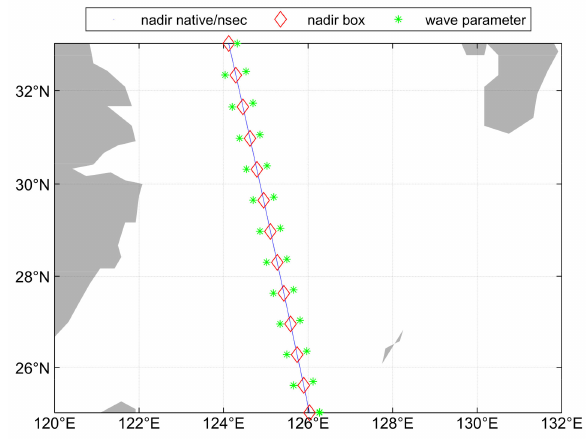
Figure 2. Diagram of locations of different SWH data.